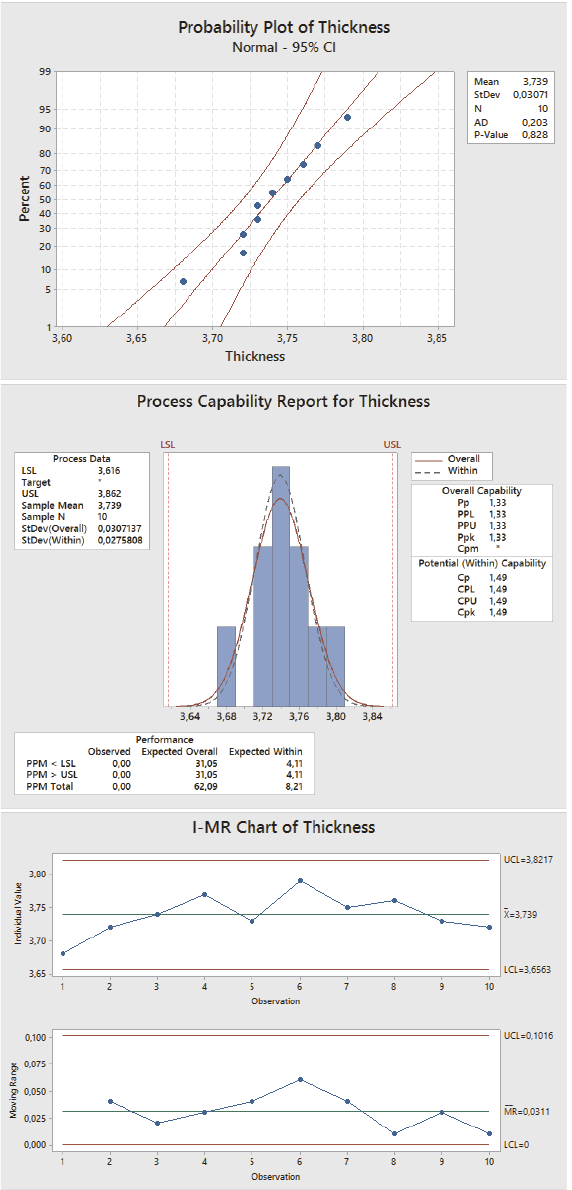
Figure 21: Probability Plot, Process Capability Report and I-MR Chart for the thickness of specimens.